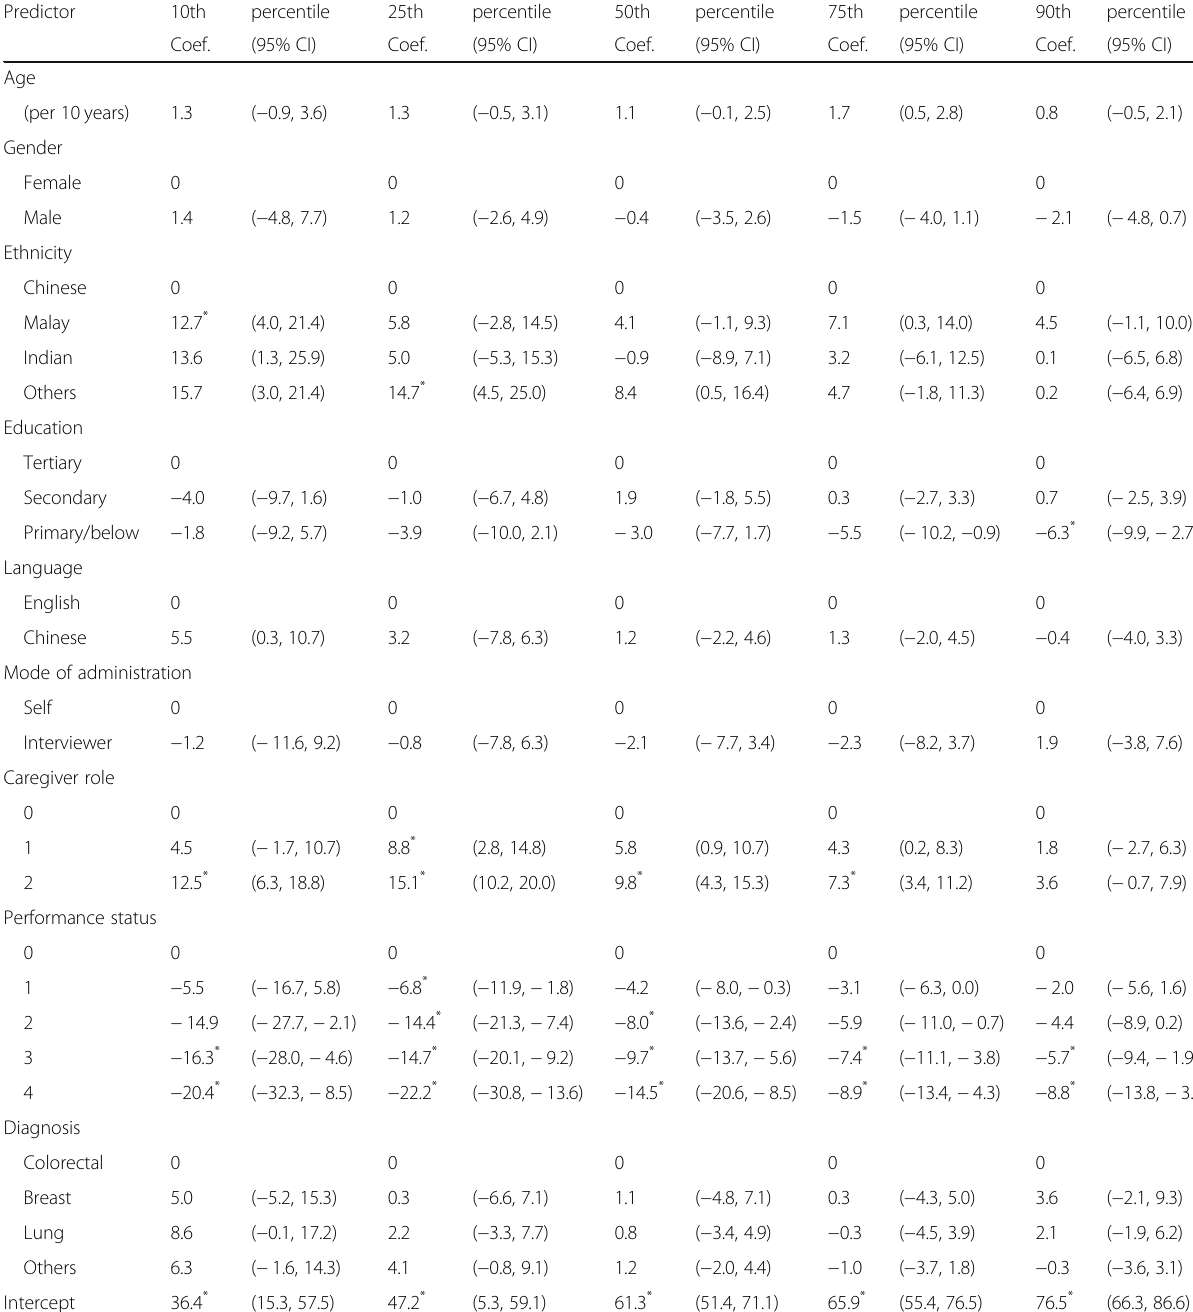
Table 2 Percentiles of QOL total score, initial model